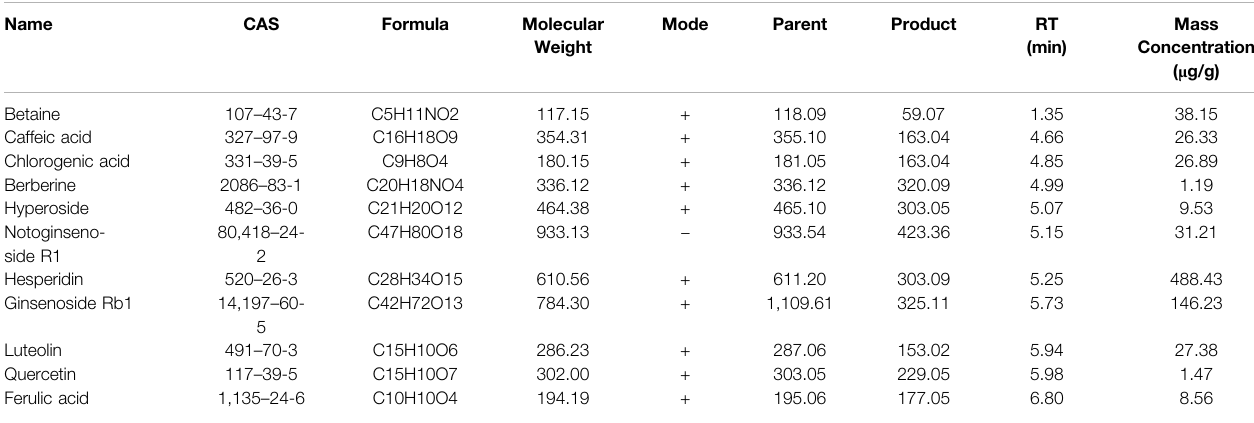
TABLE 1 | Standard spectrum information and contents of the 11 compounds in